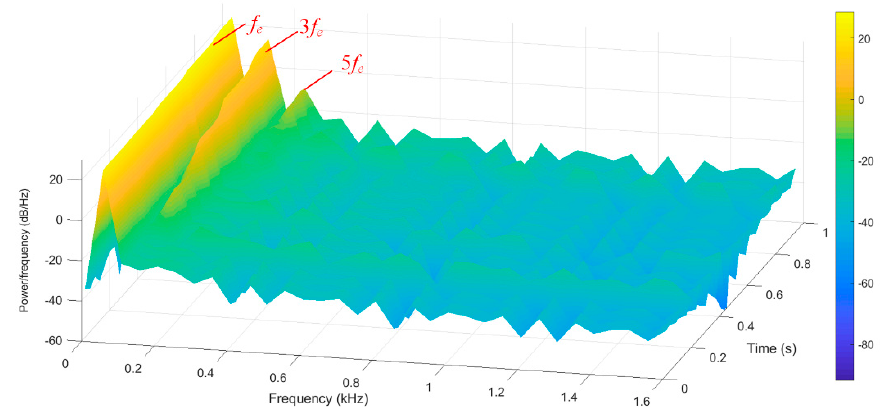
Figure 6. Time–frequency spectrum of A-phase current with fault injection. Figure 6. Time-frequency spectrum of A-phase current with fault